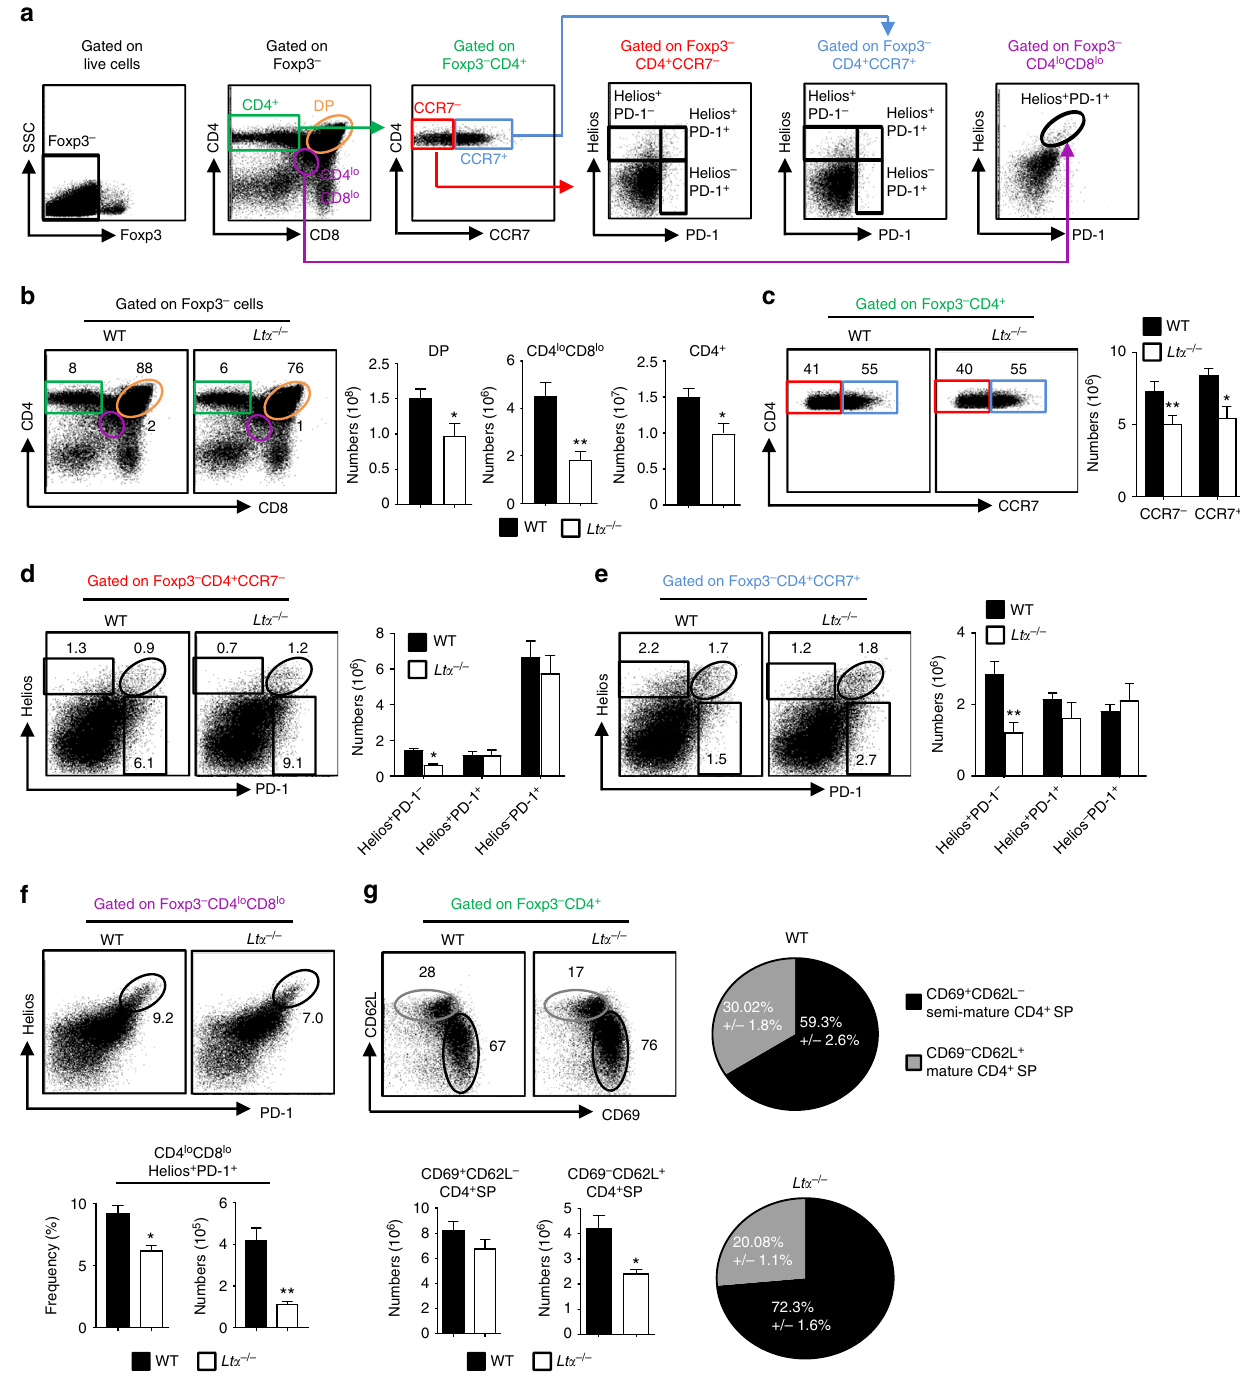
Fig. 6 Enhanced clonal deletion in the thymus of Lt α − / − mice. a Gating strategy used to analyse thymocyte subsets by fl ow cytometry. Foxp3 − cells were analysed for CD4 and CD8 expression. Foxp3 − CD4 + SP (CD4 + CD8 − ) cells were analysed for the expression of CCR7. CCR7 − CD4 + , CCR7 + CD4 + SP and CD4 lo CD8 lo cells were analysed for the expression of Helios and PD-1. b , c Flow cytometry pro fi les and numbers of DP, CD4 lo CD8 lo and CD4 + SP thymocytes ( b ) and CCR7 - CD4 + and CCR7 + CD4 + SP cells ( c ). d – f Flow cytometry pro fi les and numbers of Helios + PD-1 − , Helios + PD-1 + and Helios − PD-1 + cells in CD4 + CCR7 − ( d ), CD4 + CCR7 + ( e ) and CD4 lo CD8 lo cells ( f ) in the thymus from WT and Lt α − / − mice. g Flow cytometry pro fi les, frequencies and numbers of CD69 + CD62L − semi-mature and CD69 − CD62L + mature in Foxp3 − CD4 + SP thymocytes from WT and Lt α − / − mice. b – g Data are representative of two independent experiments ( n = 4 mice per group and per experiment). Error bars show mean ± SEM, * p < 0.05, ** p < 0.01 using one- tailed Mann – Whitney